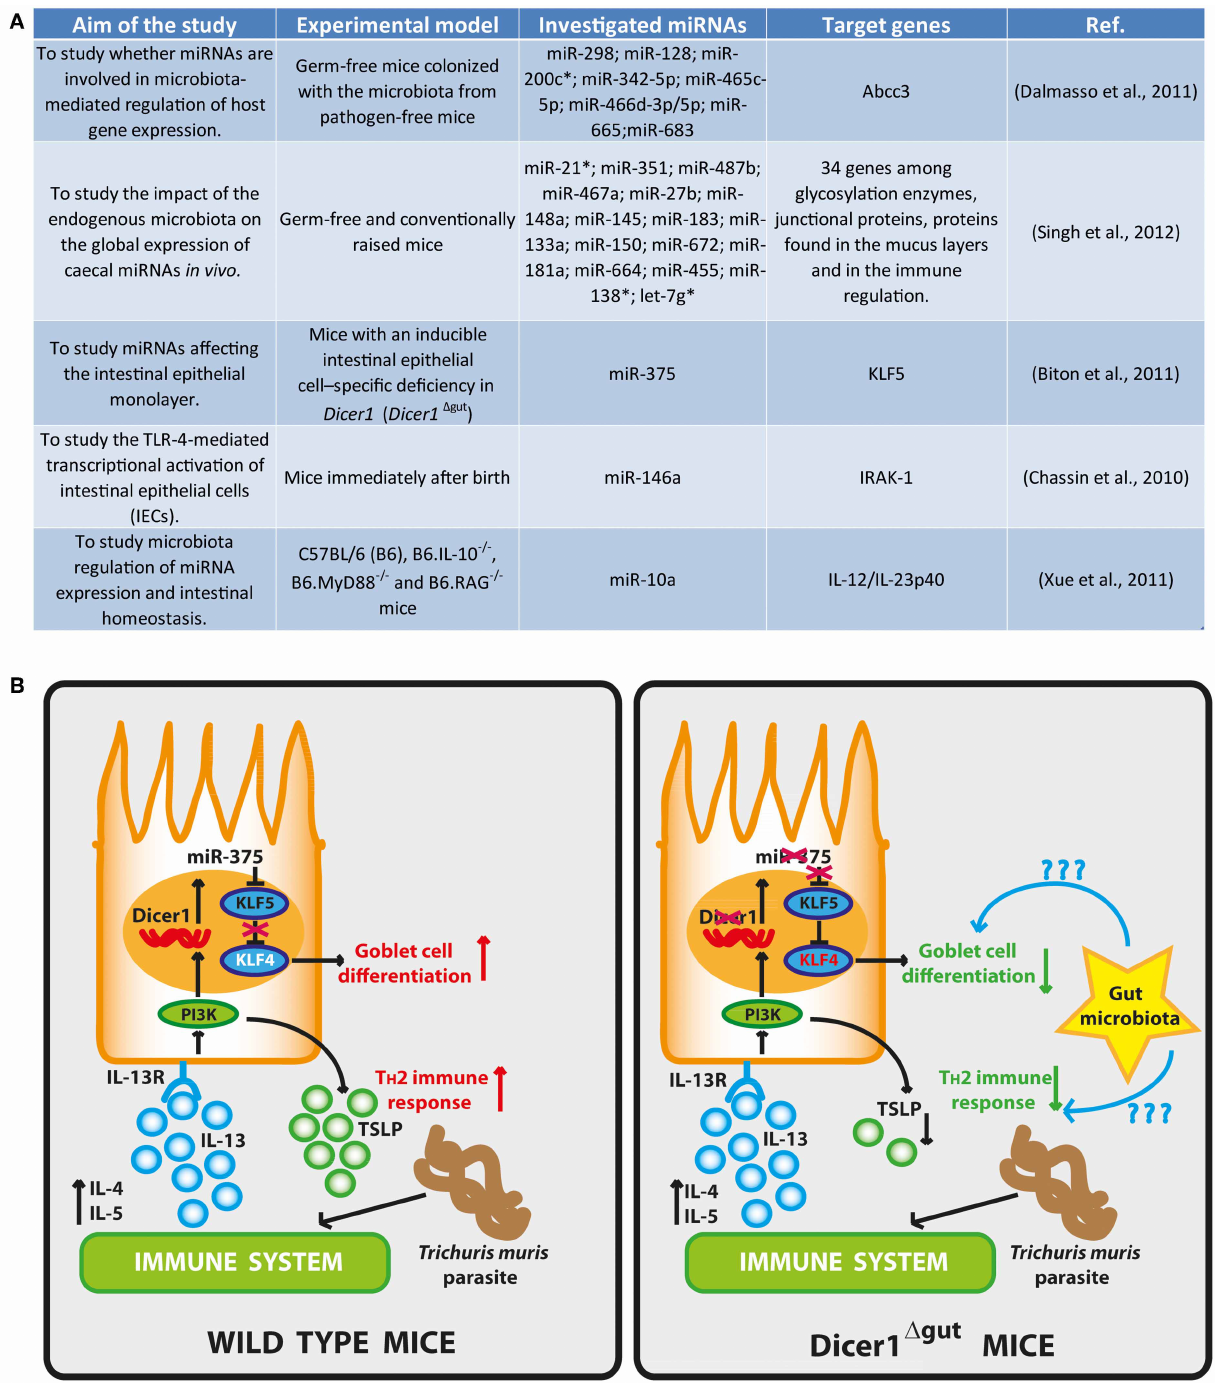
accelerate T H 2 immune responses to parasite infections. In Dicer1 (cid:2) gut mice, depletion of Dicer1 or miR-375 results in fewer goblet cells and diminished T H 2 responses. The gut microbiota can be involved in the induction and regulation of miRNA expression either for active or quiescent immunity. Likewise, other miRNAs can be involved in the generation of optimal protective immunity to various pathogens. This figure has been adapted from (Goto and Kiyono,